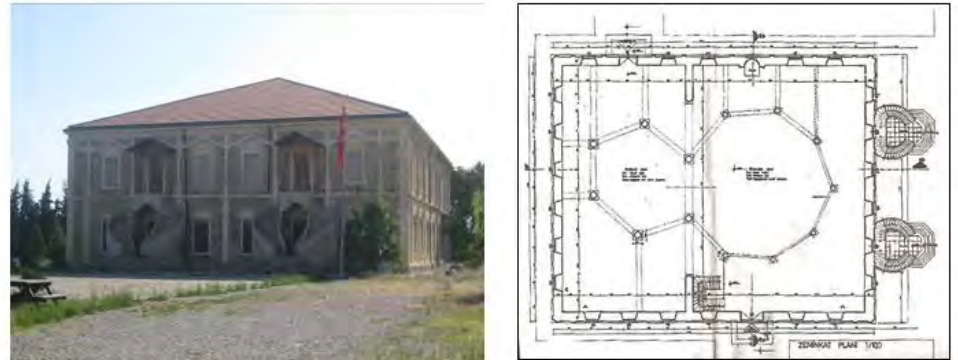
Figure 4. Mevlevihanof Gelibolu / Example of Tomb - Semahane (Yazici, 2009)